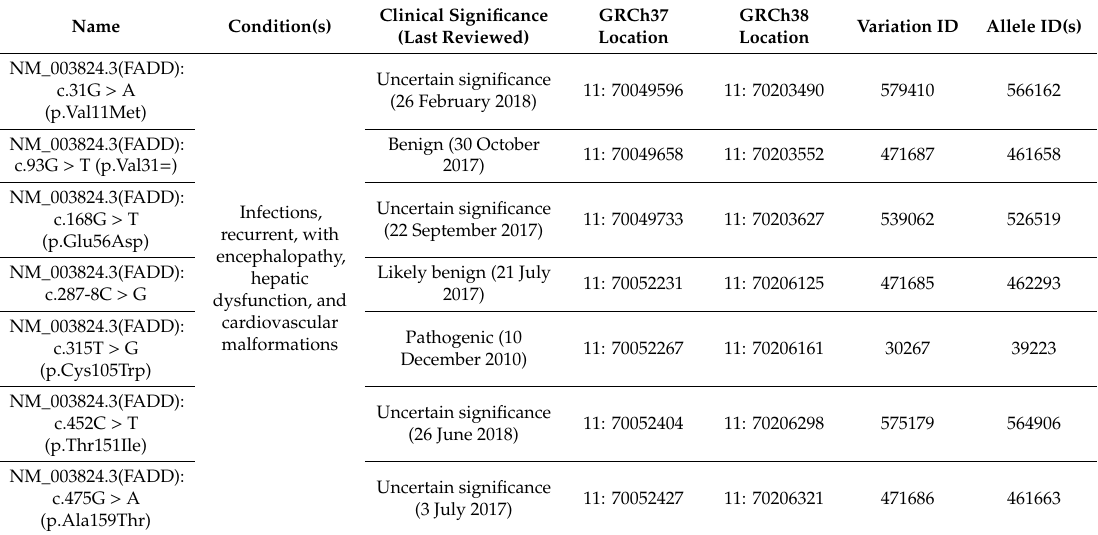
Table 1. ClinVar search results for FADD [gene] and “single gene”